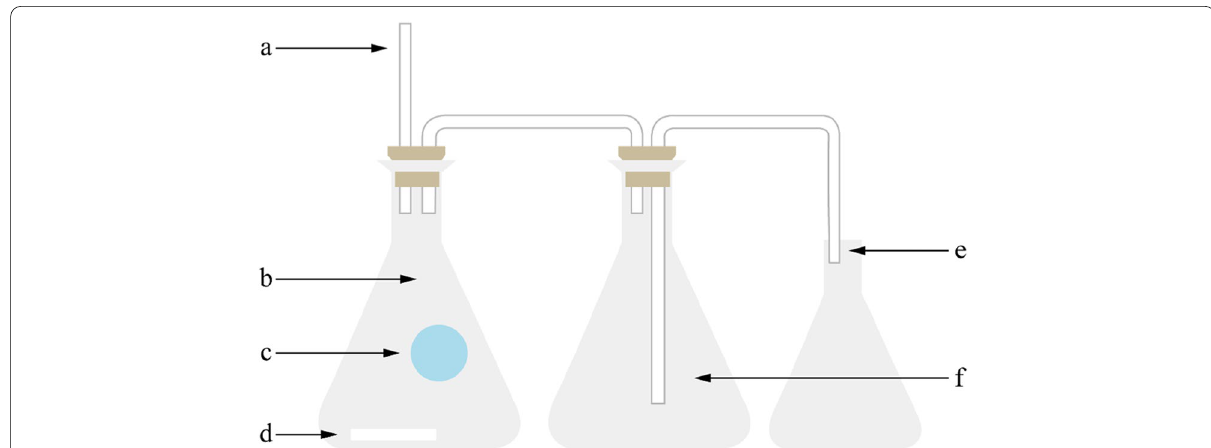
Fig. 1 Experimental set up for E. prolifera anaerobic digestion. a Nitrogen inlet; b Variable size water ball with rubber as outer package; c Fermentation broth; d Magnetic stirrer; e Water; f Drainage